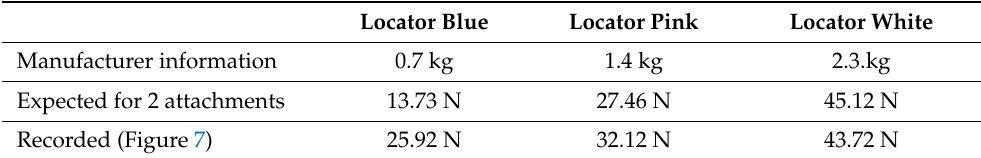
Table 4. Comparison of retention forces expected based on manufacturer’s data and values recorded